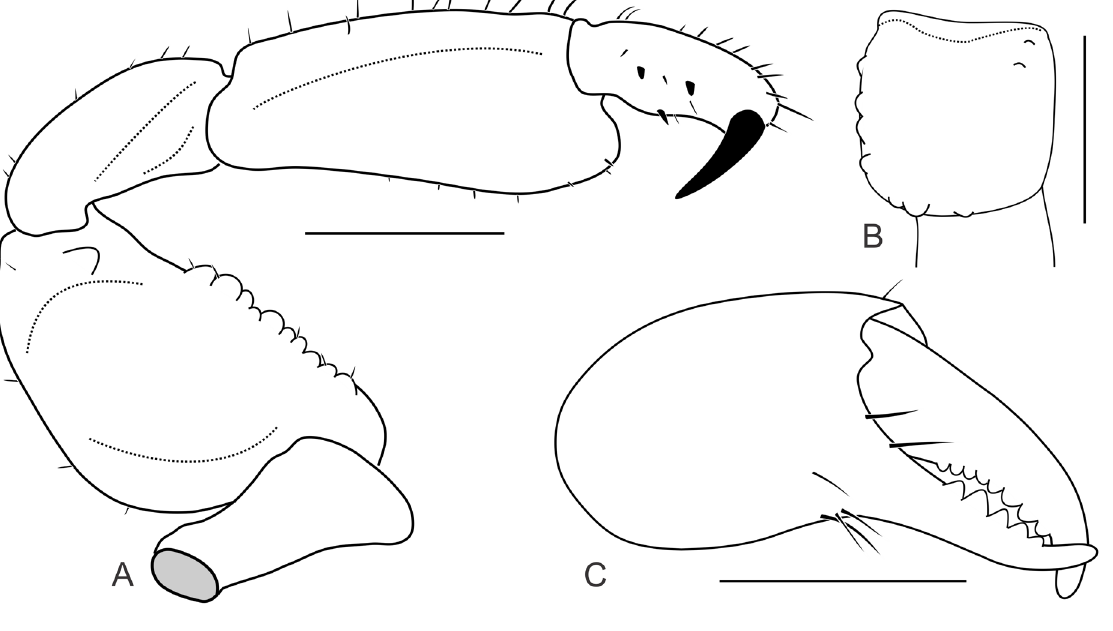
Fig. 3. Libitia bipunctata Sørensen, 1932, ♂ (ICN-AO 470). A . Left pedipalp, ventral view. B . Left cheliceral hand, dorsal view. C . Left chelicera, dorsal view. Scale bars = 1